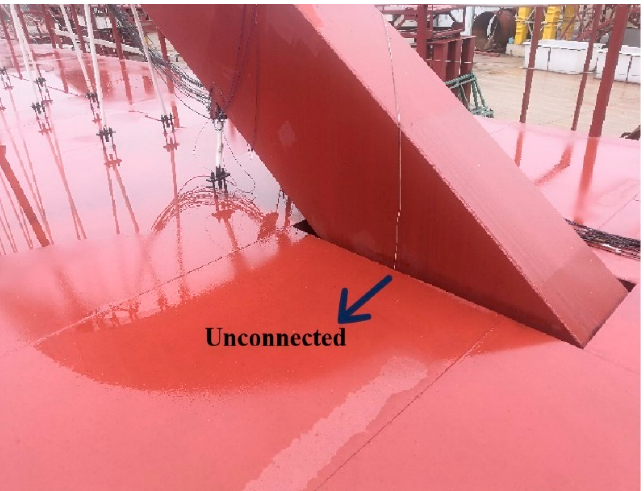
Figure 4. Skewback of HTABs and TABs with a floating deck structure.